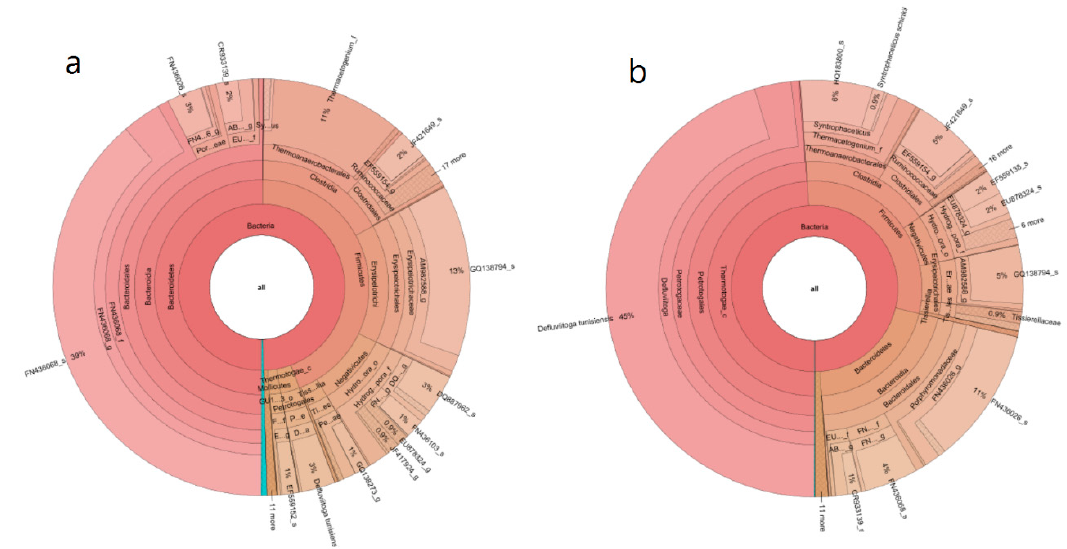
Figure 3. Results of bacterial communities analysis in AD ( a ) and BEAD ( b ) reactors at the end of S2 (4.0 kg/m 3 ·d).